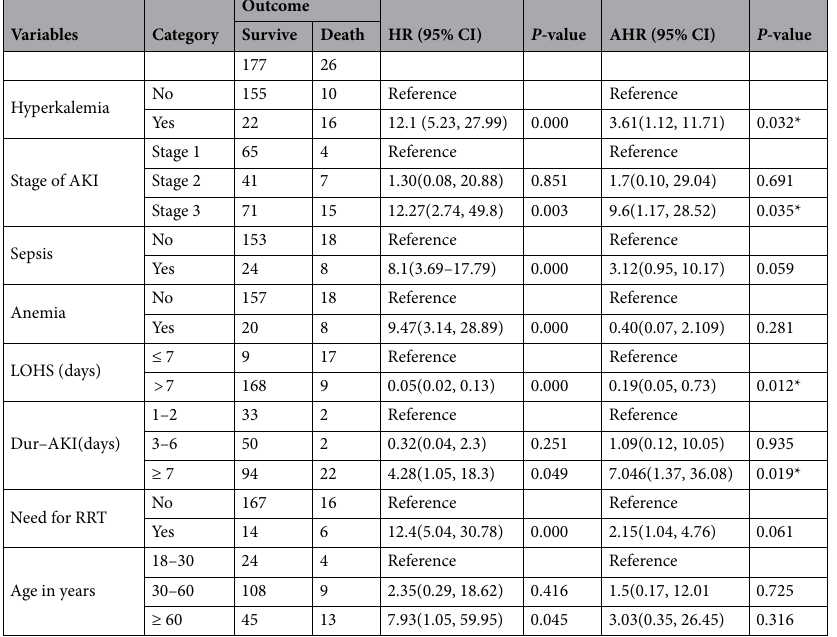
Table 5. Bivariate and multivariate cox regression analysis of predictors of mortality (n = 26). AKI, acute kidney injury; HR, hazard ratio; AHR, adjusted hazard ratio; CI, confidence interval; LOHS, length of hospital stay; Dur-AKI, duration of AKI; RRT, renal replacement therapy. *Statistically